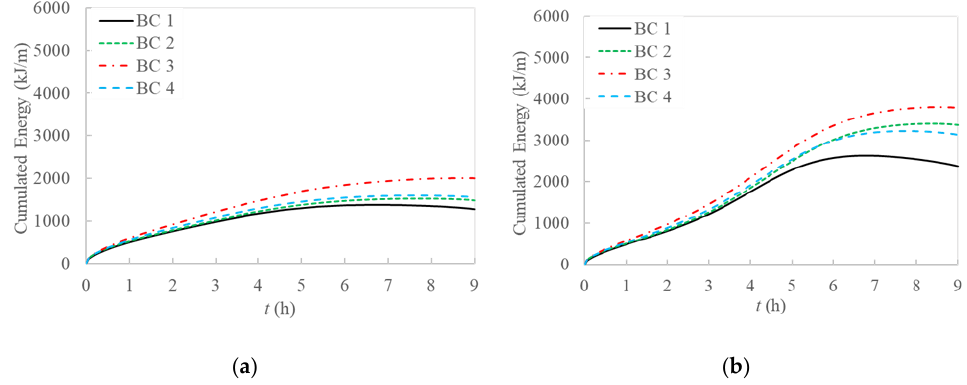
Figure 9. Cumulated energy for 2D model: ( a ) without natural convection; ( b ) with natural convection included in the model.